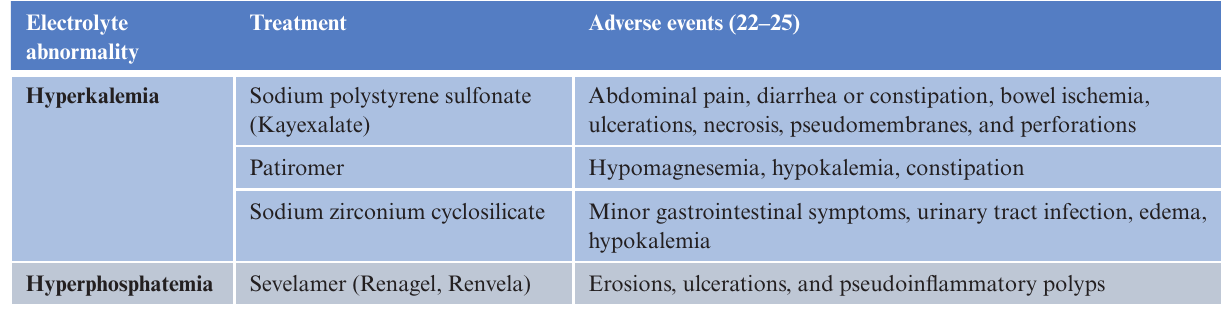
Table 1: The use of medical resins in the management of electrolyte abnormalities in kidney failure and their associated adverse